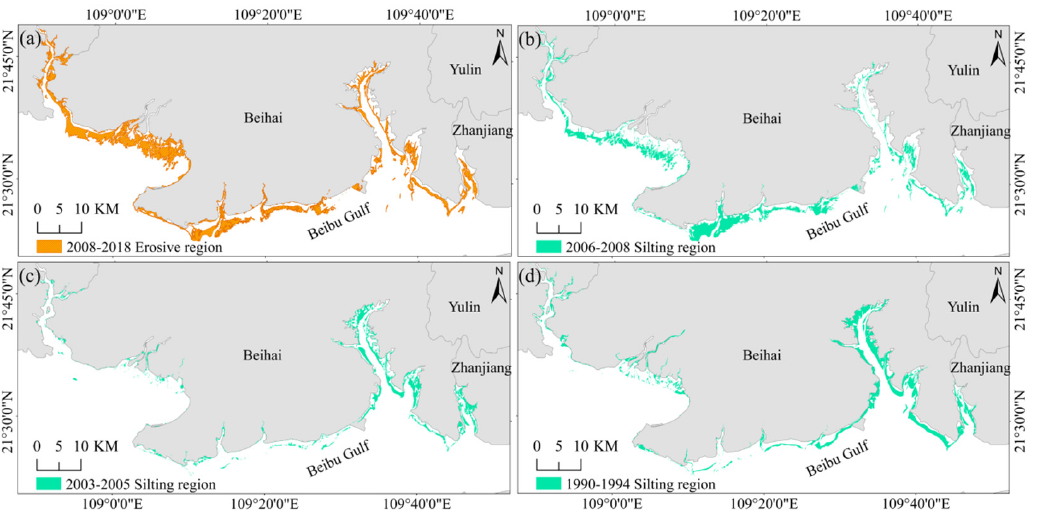
Figure 12. Distribution of spatio-temporal siltation and erosion of tidal flats in the Beihai shore section. ( a ) Erosion distribution of tidal flats in Beihai shore section from 2008 to 2018. ( b ) Siltation distribution of tidal flats in Beihai shore section from 2006 to 2008. ( c ) Siltation distribution of tidal flats in Beihai shore section from 2003 to 2005. ( d ) Siltation distribution of tidal flats in Beihai shore section from 1990 to